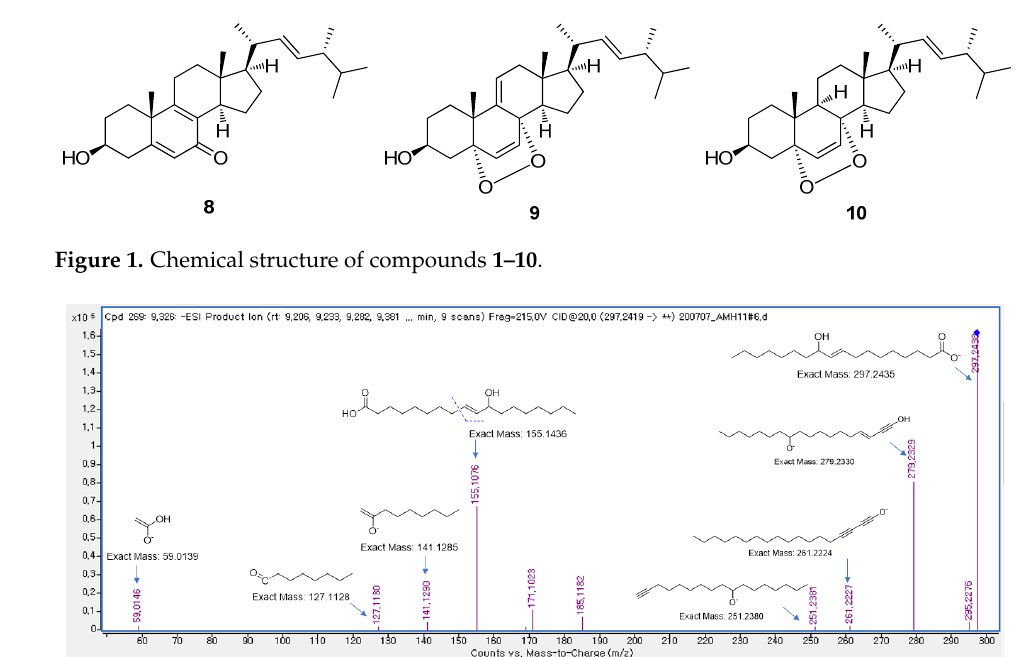
Figure 2. MS/MS data (MS 2 297.2 [M − H] − → full ‐ scan) and fragmentation pathways of compound 1 .